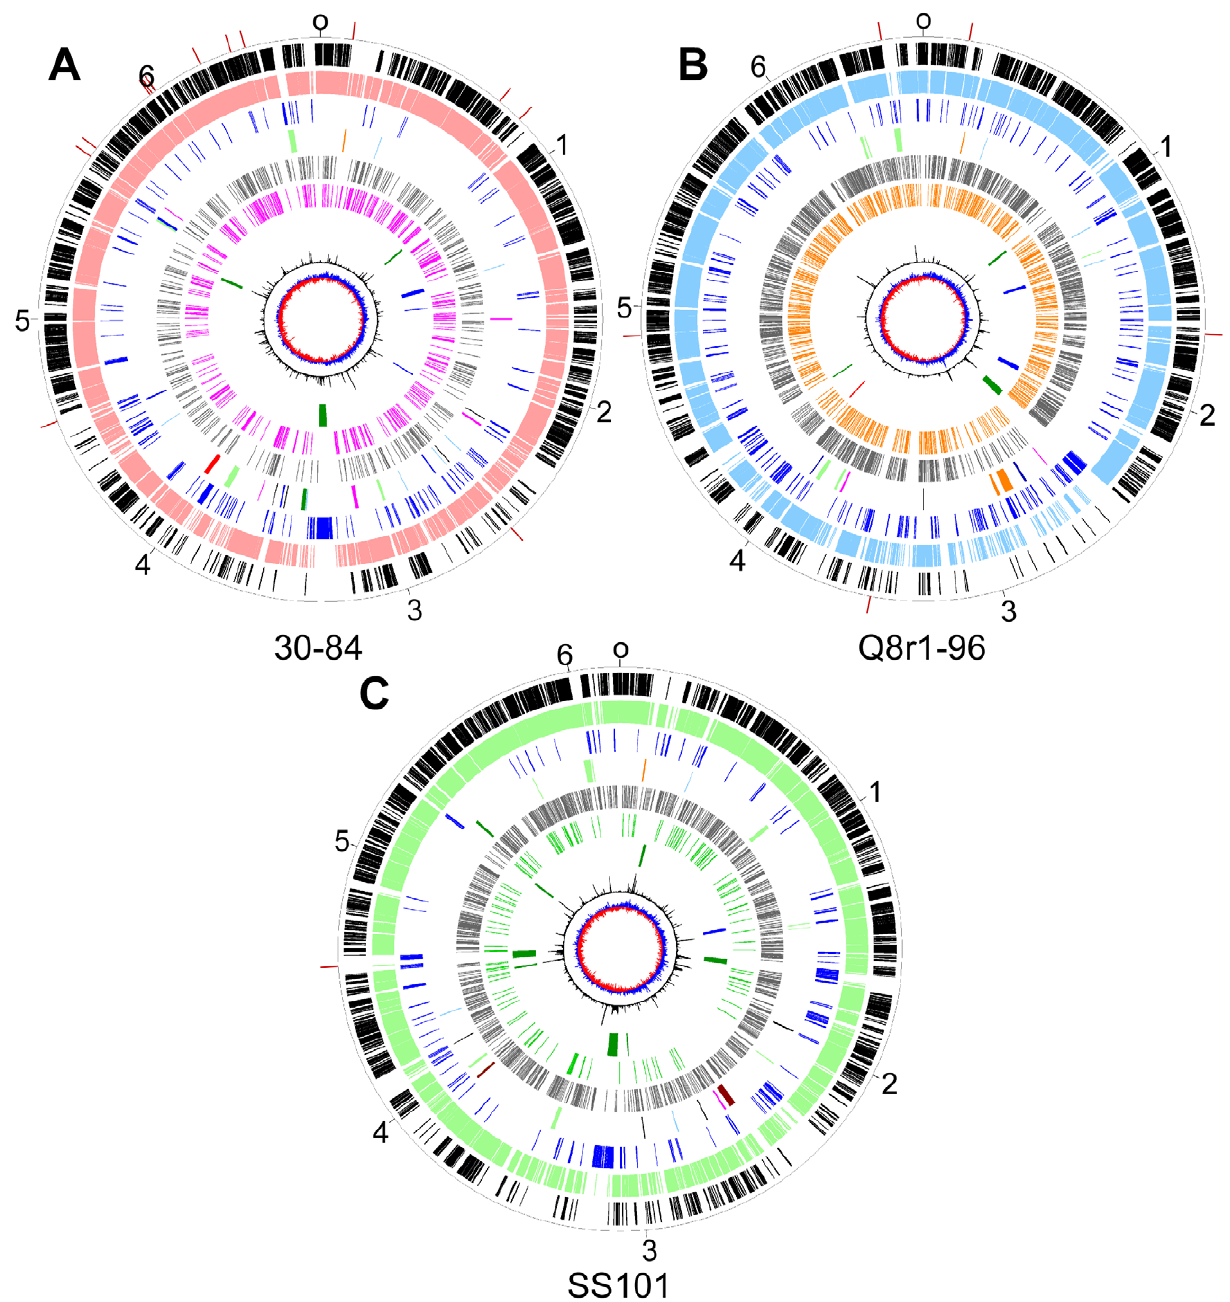
Figure 3. Circular genome diagrams of representative strains from each of three sub-clades in the P.fluorescens group. P. chlororaphis 30-84, Sub-clade 1 (A); P. brassicacearum Q8r1-96, Sub-clade 2 (B), and; P. fluorescens SS101, Sub-clade 3 (C). The outer scales designate the coordinates (in Mb) and the red marks indicate the boundaries of scaffolds. The first (outer-most) circles show the core genes shared across P. aeruginosa , P. syringae , P. putida and the P. fluorescens group (black). The second circles show the core genes conserved within each respective sub- clade (Sub-clade 1, pink; Sub-clade 2, blue, and; Sub-clade 3, green). The third circles show genes unique to each strain (blue). The fourth circles show the locations of genes or gene clusters coding for the production of antibiotics (blue), cyclic lipopeptides (brown), siderophores (dark green), orphan clusters (orange), bacteriocins (light blue), plant communication (magenta), exoenzymes (black), secretion systems (light green) or insect toxins (red). The fifth and sixth circles show the positions of repetitive extragenic palindromic elements; REPa (grey), REPb (magenta), REPc (green) and REPd (orange, in Q8r1-96 using the REP HMM trained on SBW25 sequences). The seventh circles show the locations of putative mobile genetic elements; genomic islands (dark green), prophage (blue) and transposons (red). The eighth circles show the trinucleotide content (black lines) and the ninth circles show the GC-skew.